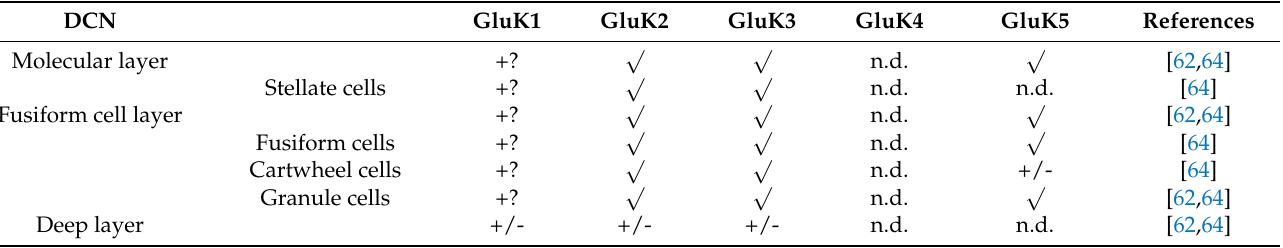
Table 1. Expression of KAR subunits in the